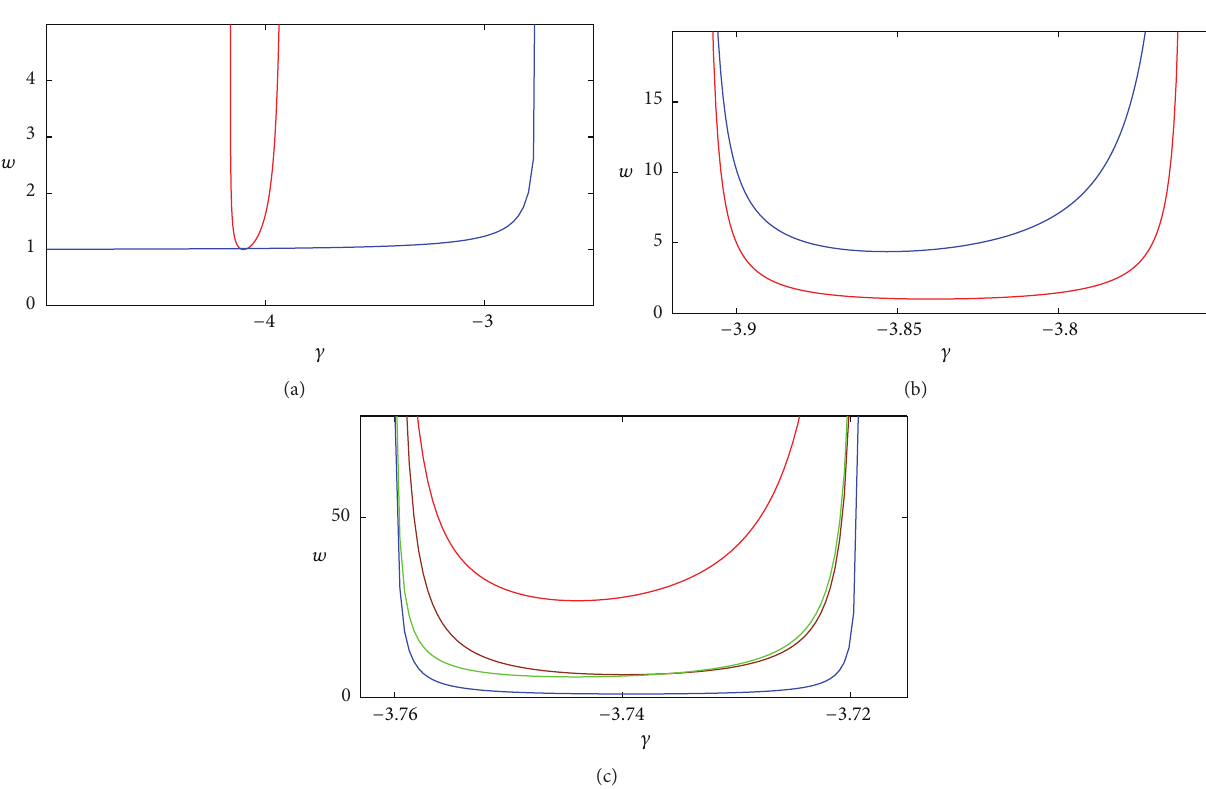
Figure 4: Stochastic sensitivity functions: (a) for equilibria 𝑀 1 , 𝑀 2 , (b) for 2 cycles, and (c) for 4 cycles.